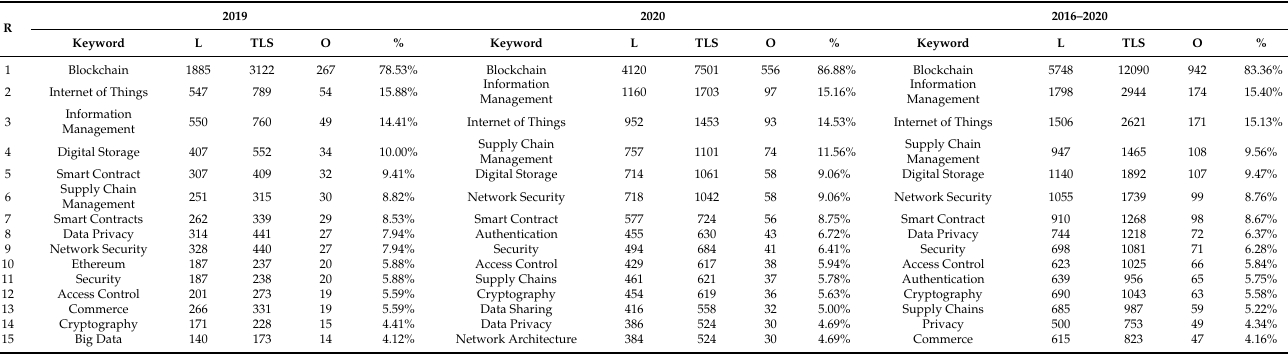
Table 3. Top 15 keywords per period (2019, 2020 and